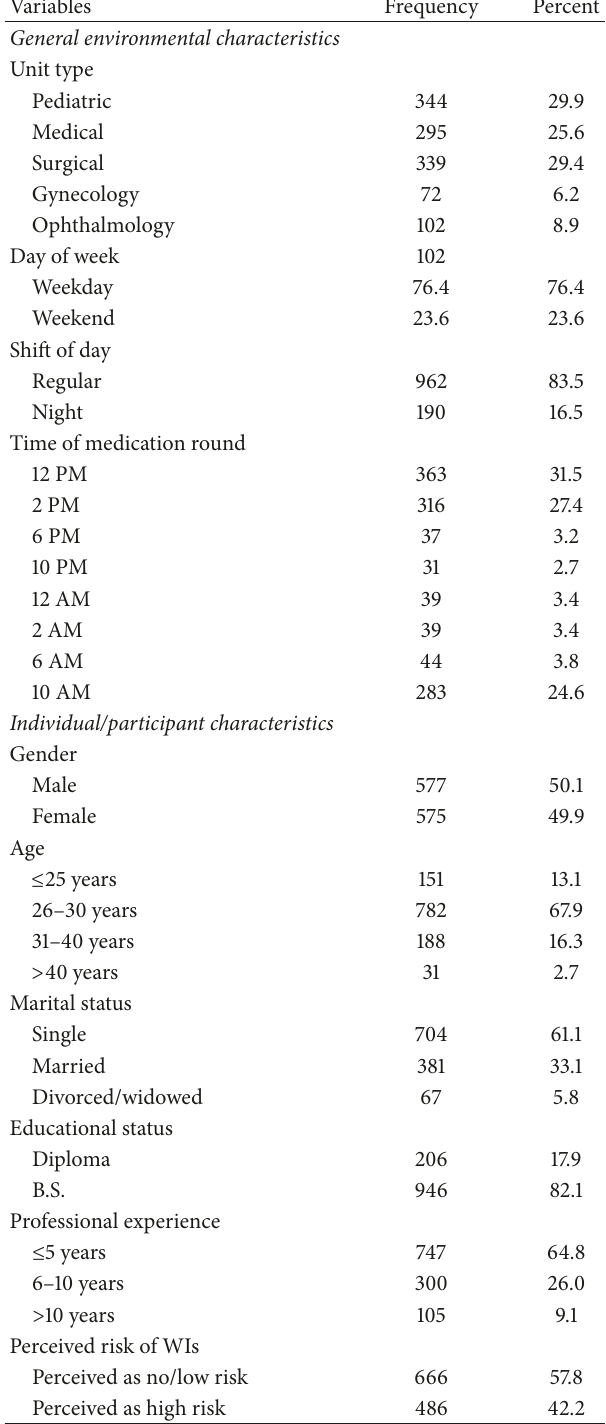
Table 2: Participants’ frequency and percentage distribution of work interruptions during the phases of medication administration process.